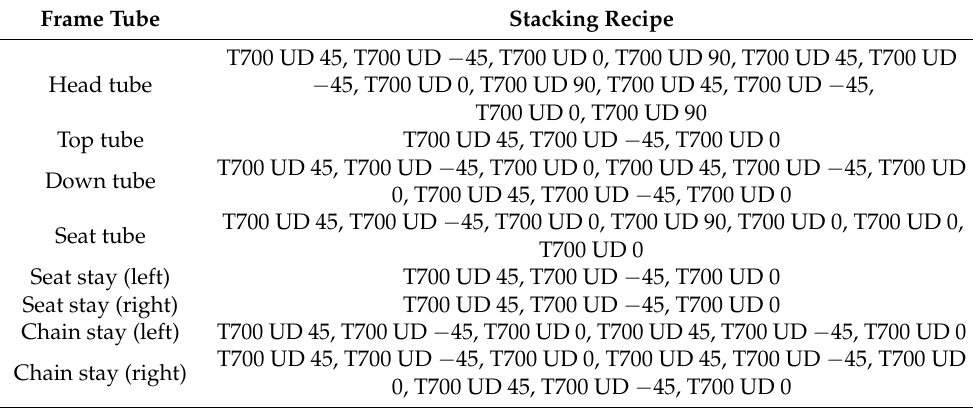
Table 13. Stacking scenario